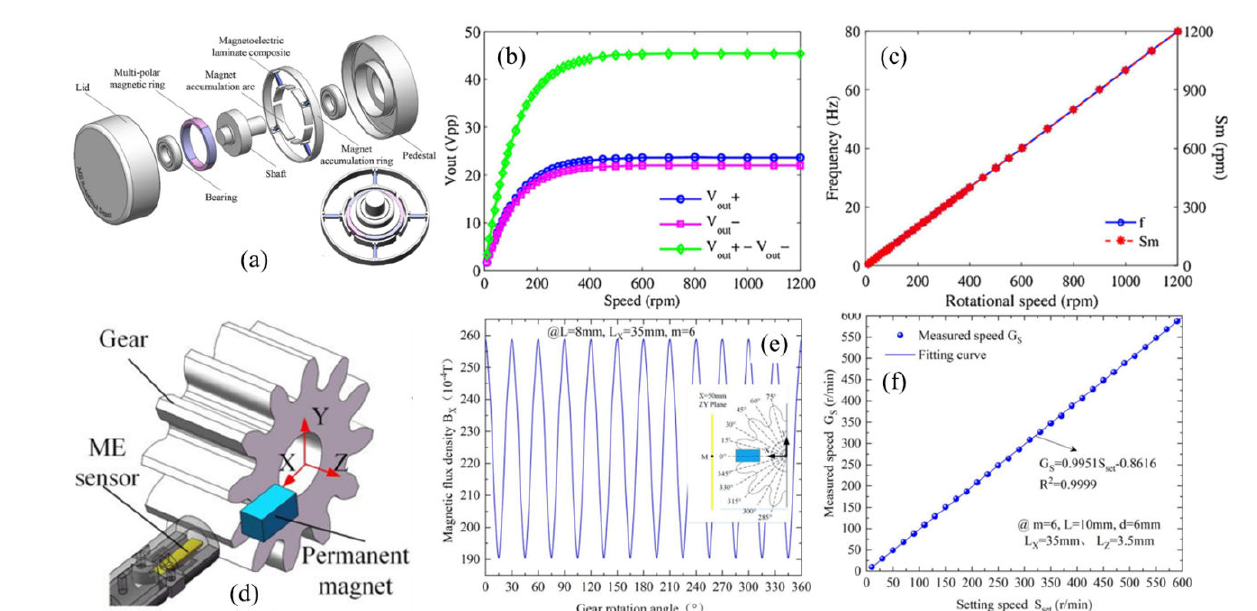
Figure 13. ( a ) Schematic view of the packaged sensor; ( b ) The peak-to-peak values under different rotational speed; ( c ) The frequency of the output signal as a function of the rotational speed [81]. ( d ) Schematic layout of the gear, permanent magnet and FeCoSiB/Pb(Zr,Ti)O 3 sensor; ( e ) The magnetic flux density with the gear rotates one circle ( f ) the measurement speed (G s ) under different rotational speed